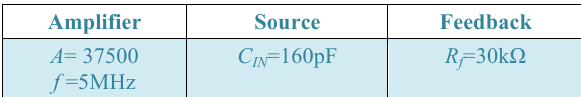
TABLE II. THE COMPONENTS OF THE TRANSIMPEDANCE AMPLIFIER FREQUENCY